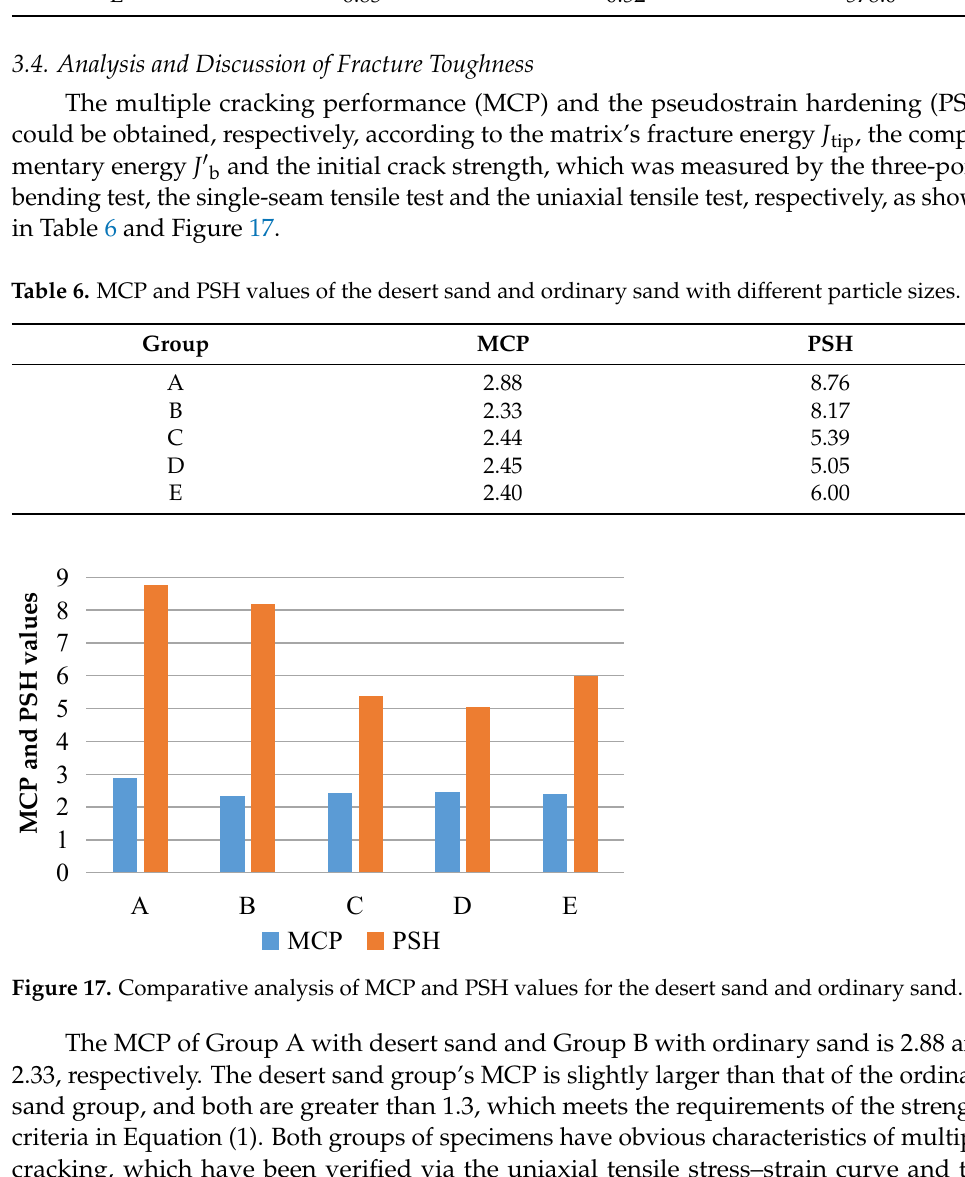
Table 5. Complementary energy of the ECC single-seam cracking test.